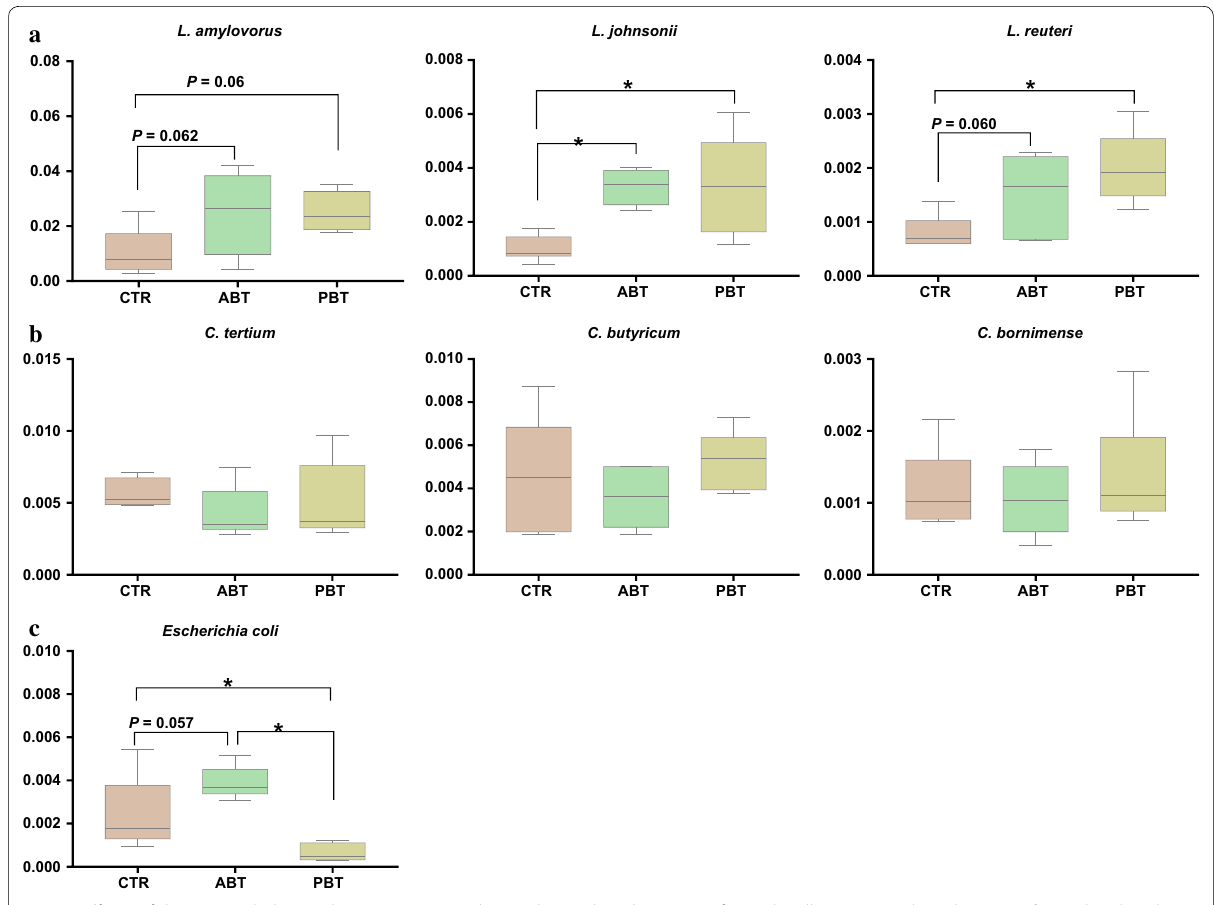
Fig. 4 Effects of dietary B. subtilis supplementation on colonic relative abundance (%) of Lactobacillus spp. ( a ), Clostridium spp. ( b ), and Escherichia coli ( c ) within the top 25 species levels of piglets. Data are expressed as mean